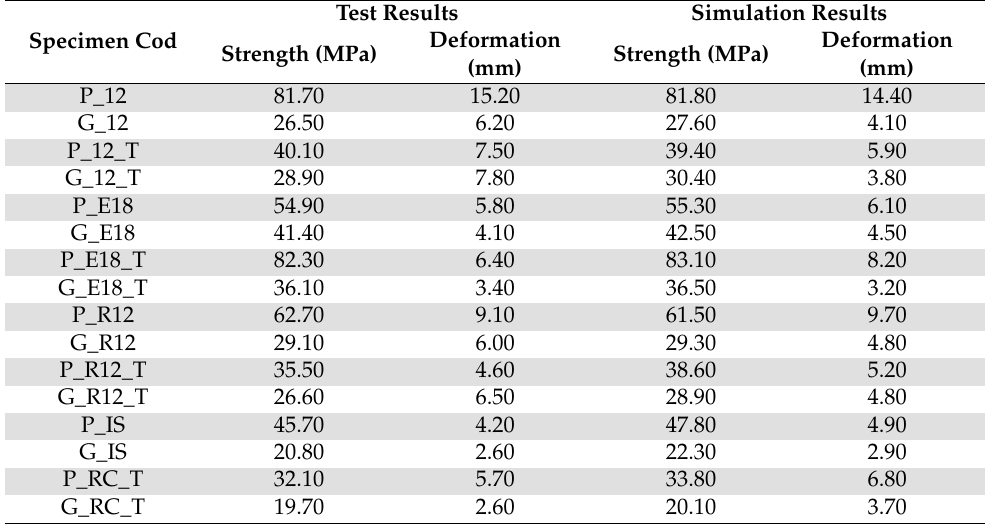
Table 2. Comparison between results of the tests and simulation, for 3D printed specimens, bending-stressed.